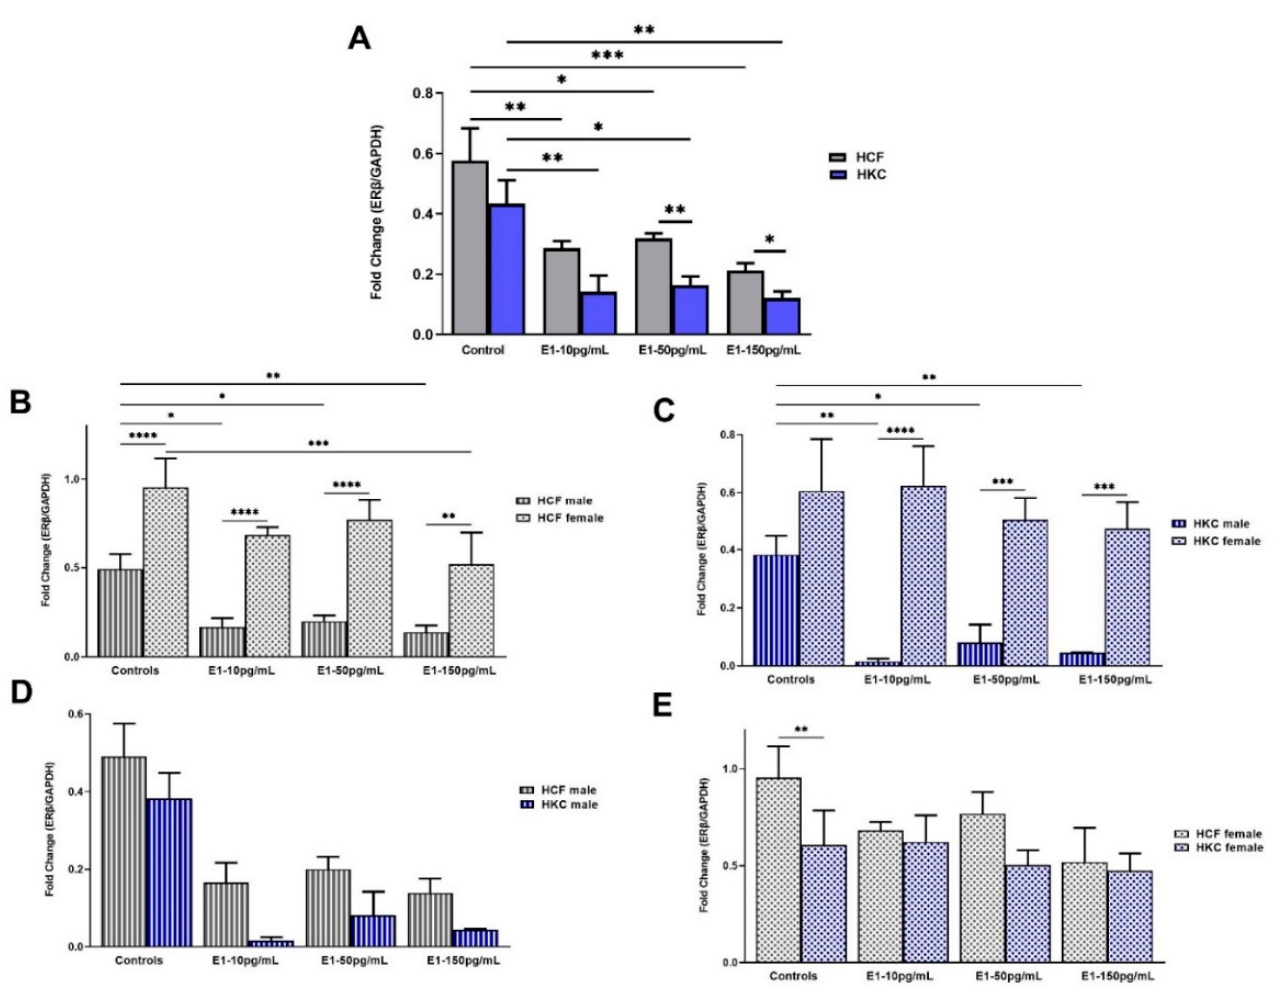
Figure 4. Expression of ER β in 3D HCFs and HKCs in response to 10, 50, 150 pg/mL E1 stimulation for four weeks. ( A ) Overall ER β expression in HCFs and HKCs ( n = 6). ( B ) Sex-specific expression of ER β in HCFs ( n = 3). ( C ) Sex-specific ER β expression in HKCs ( n = 3). ( D ) Male-specific ER β expression in HCFs vs. HKCs ( n = 3). ( E ) Female-specific expression of ER β in HCFs vs. HKCs ( n = 3). * p < 0.05, ** p < 0.01, *** p < 0.001, and **** p < 0.0001.